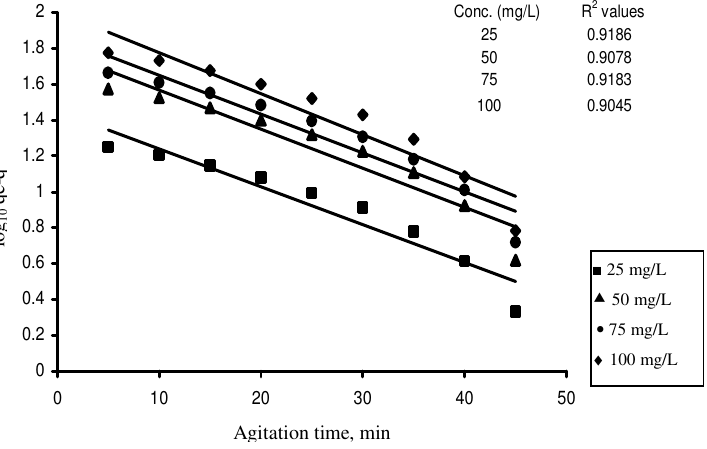
Figure 3. Lagregren plots for crystal violet